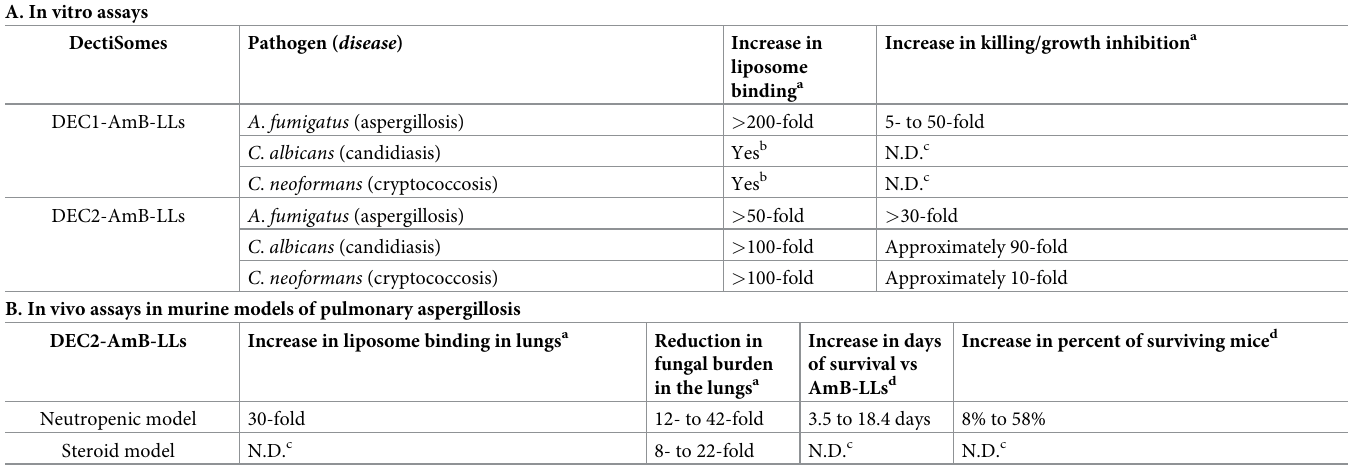
Table 1. Performance of Dectin-coated AmB-loaded liposomes targeted to fungal cells, relative to untargeted